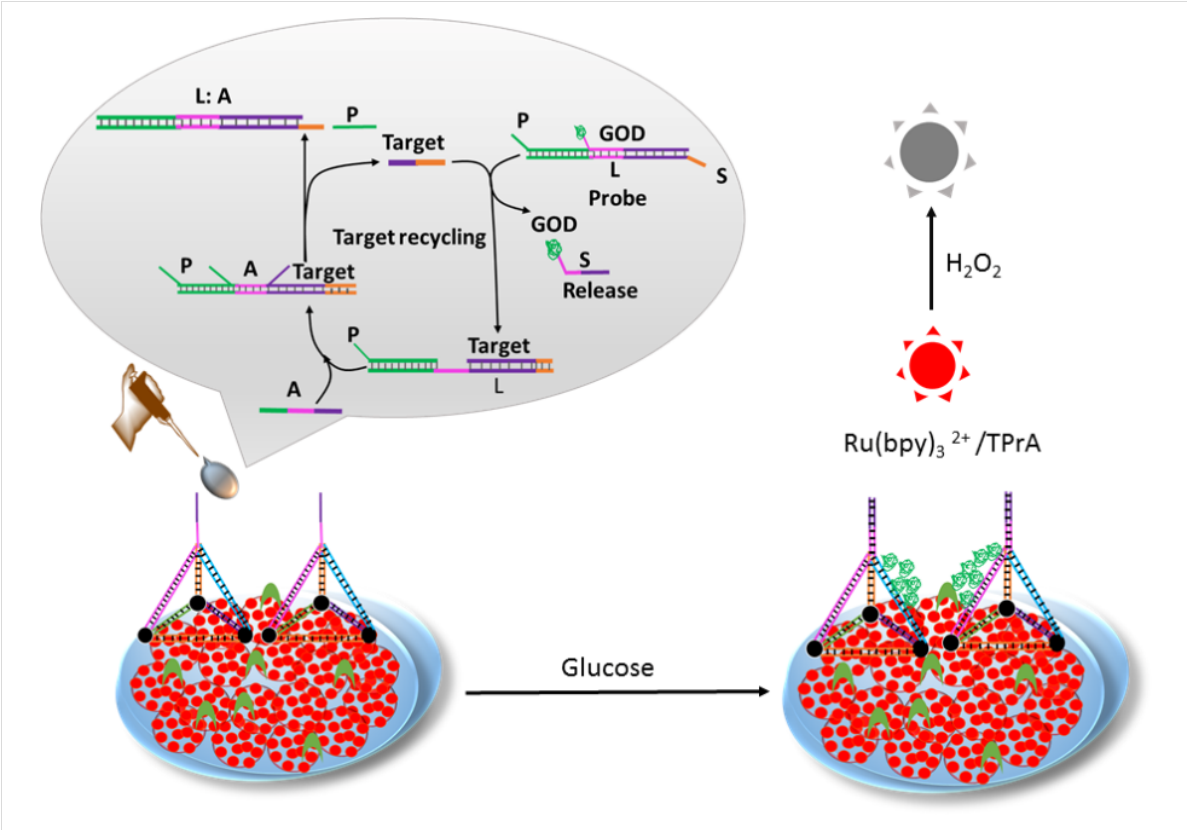
Figure 3: Schematic representation of DNA tetrahedron-based electroluminescence biosensor platforms. The image has been adapted with permis- sion from [69], copyright 2017 American Chemical Society.